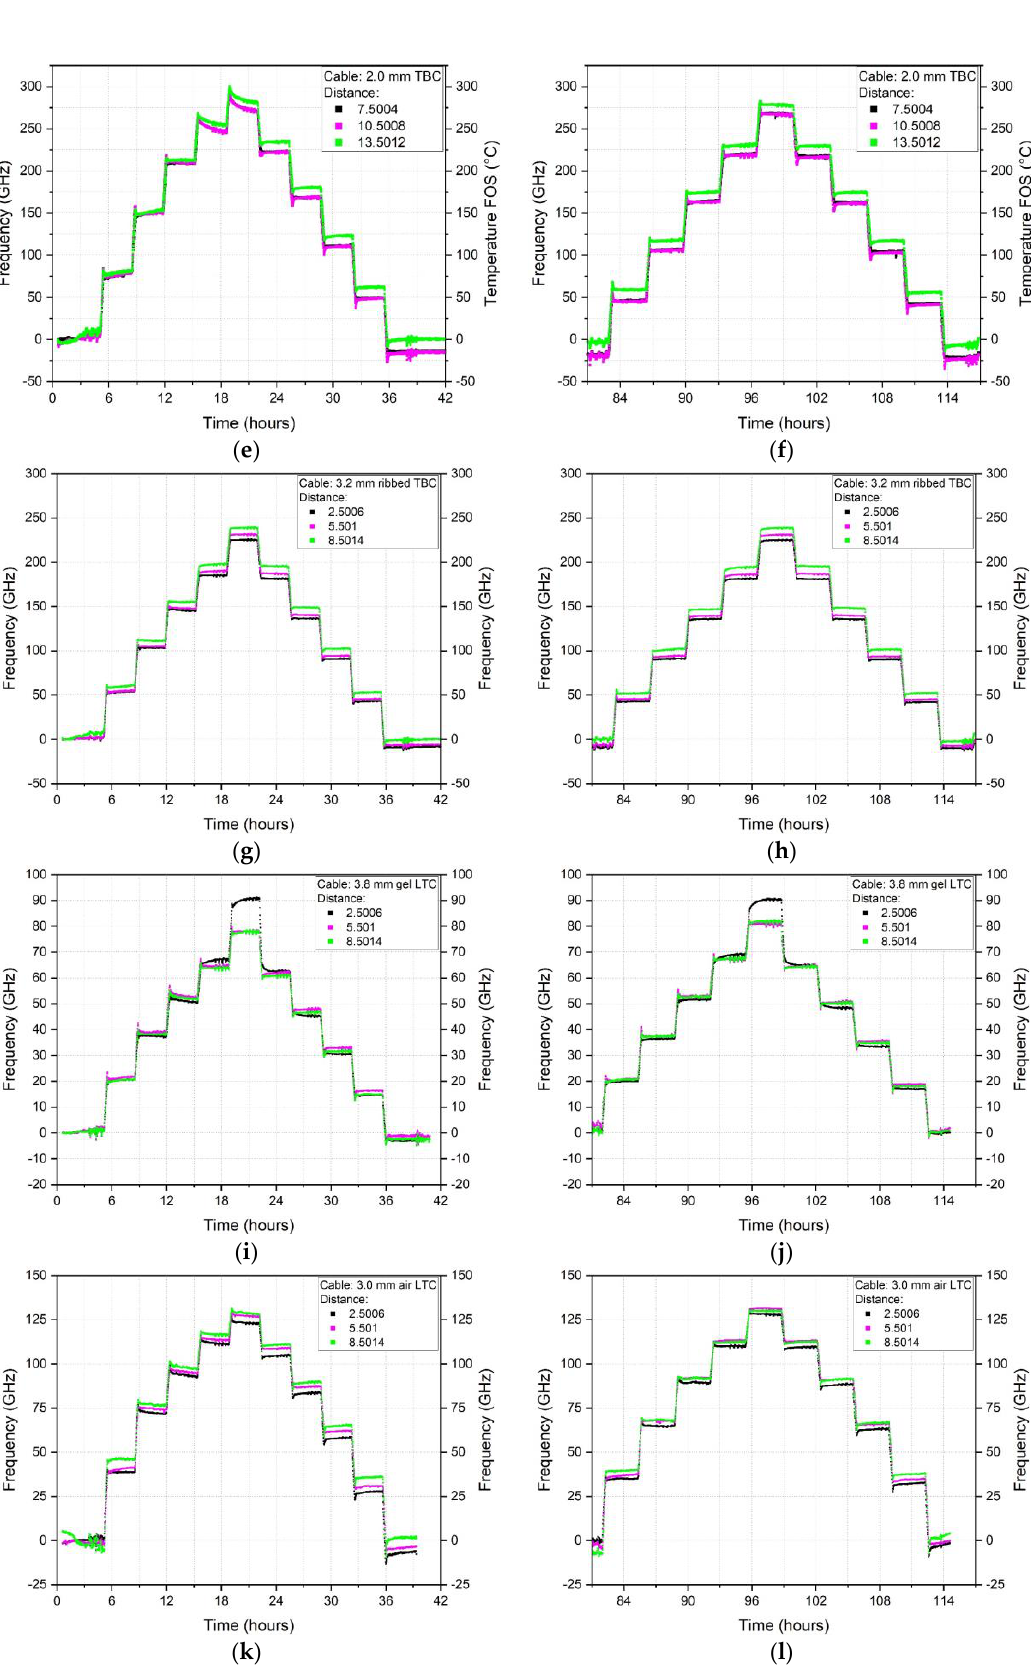
Figure A1. Time-Frequency plots for sustained temperature steps 10–60–10–10 ◦ C for bare fibre cable ( a ) 1st heating-cooling cycle, ( b ) 3rd heating-cooling cycle; 900 µ m tight buffered cable ( c )